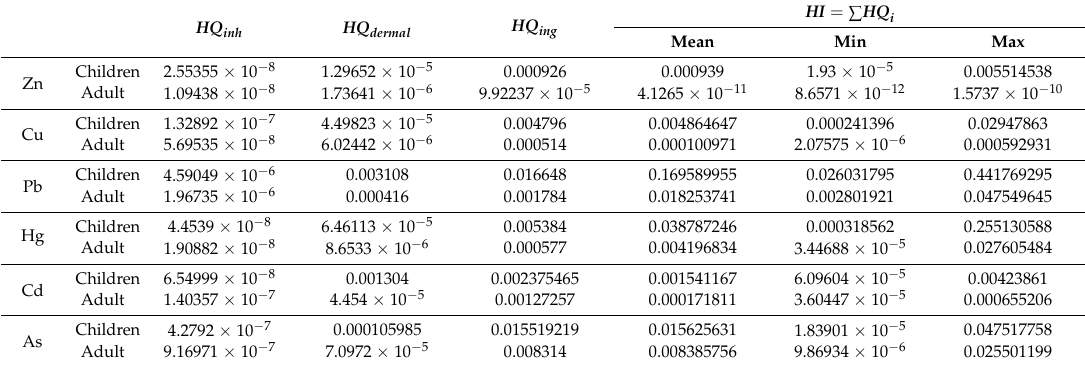
Table 3. The index of non-carcinogenic health risk.